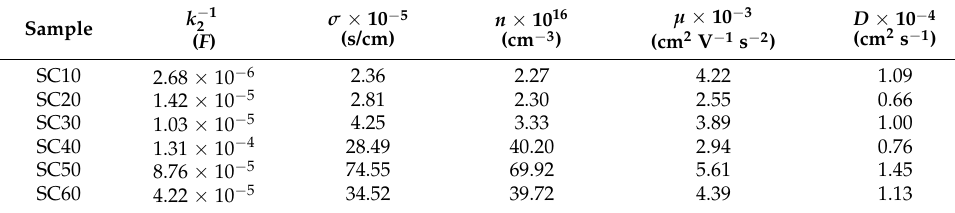
Table 3. Summary of the parameters k − 1